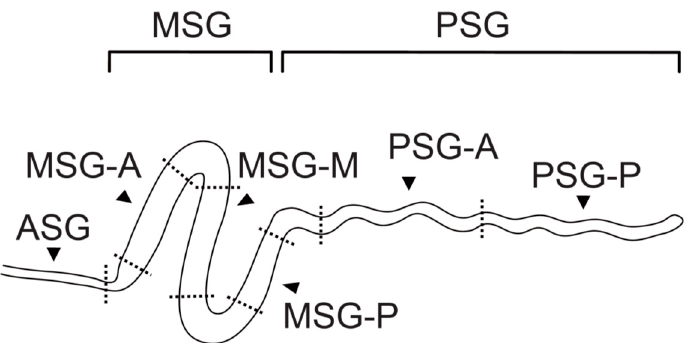
Figure 1. Schematic of the silk gland of Bombyx mori . ASG; anterior silk gland, MSG; middle silk gland, MSG-A; anterior portion of the MSG, MSG-M; middle portion of the MSG, MSG-P; posterior portion of the MSG, PSG; posterior silk gland, PSG-A; anterior half of the PSG; PSG-P; posterior half of the PSG. In order to avoid contamination of the neighbor regions, each portion was prepared as shown in this figure. The structural border is not observed in the PSG, and so the long tubular tissue was divided simply into the anterior and posterior halves.